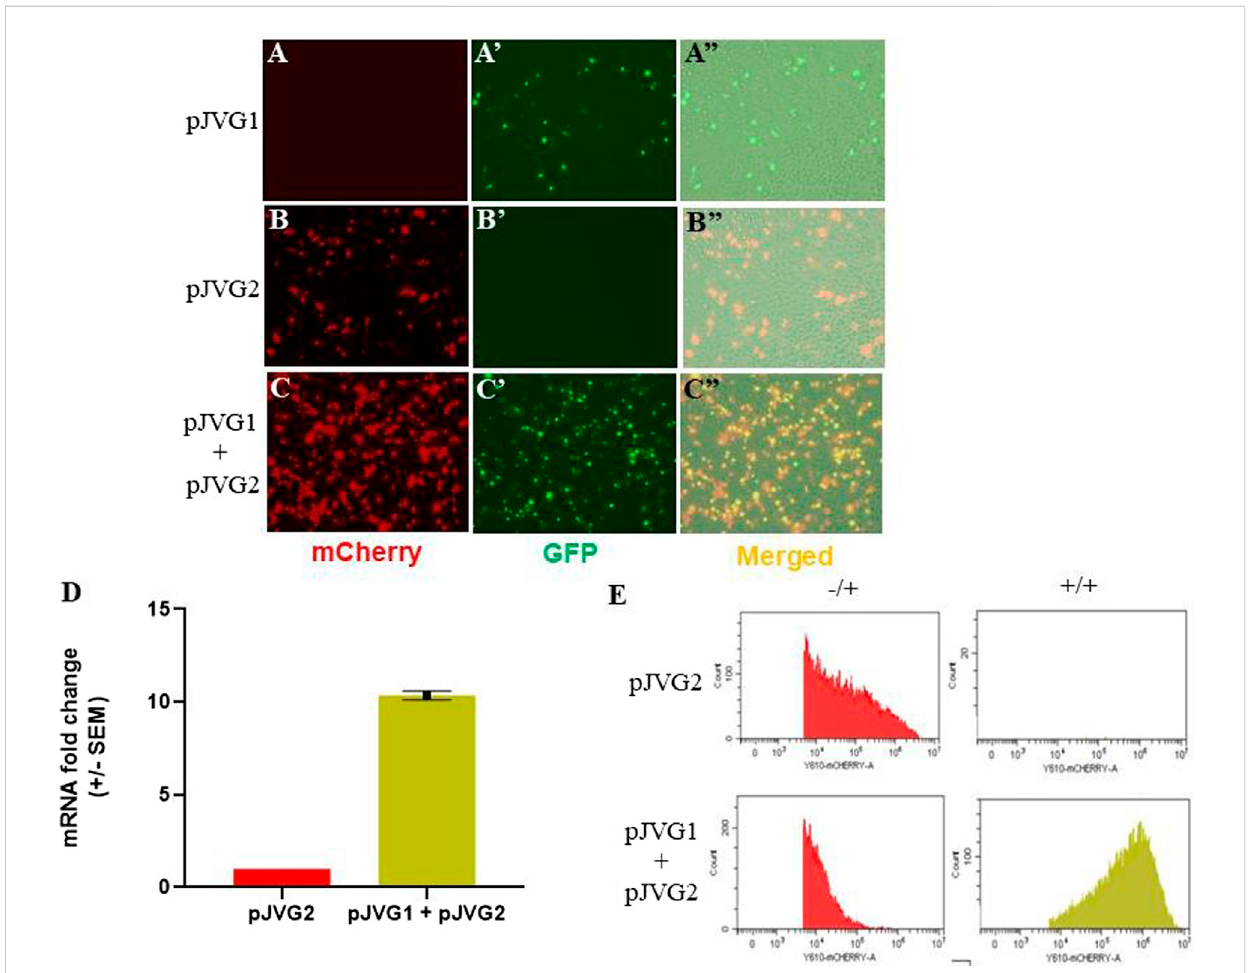
Functional validation of CRISPR activation in Aedes cells. C6/36 cells were transfected with either pJVG1 (A-A ” ) , pJVG2 (B-B ” ) or pJVG1 and pJVG2 plasmids simultaneously (C-C ” ) and imaged using fl uorescence microscopy 48 h post-transfection. Compared with dCas9-VPR alone, an increased intensity of the mCherry fl uorescent signal was observed in cells expressing dCas9-VPR and tetO guide RNA indicating increased mCherry proteinlevels. (D) RT-qPCRanalysisshowingfold change inexpression ofmCherrymRNAincells transfectedwith pJVG2alone and co-transfected with pJVG1 and pJVG2. The data is shown for two independent biological samples. (E) Histogram plot showing the intensity of mCherry protein in cells transfectedwithpJVG2(upperpanel) andpJVG1together withpJVG2(lowerpanel). Theplots inthe fi rstcolumn( − /+) arederivedfromthequadrant dot plot showing the population of only mCherry positive cells. The plots in the second column (+/+) is derived from the same dot plot showing the population of mCherry and eGFP positive